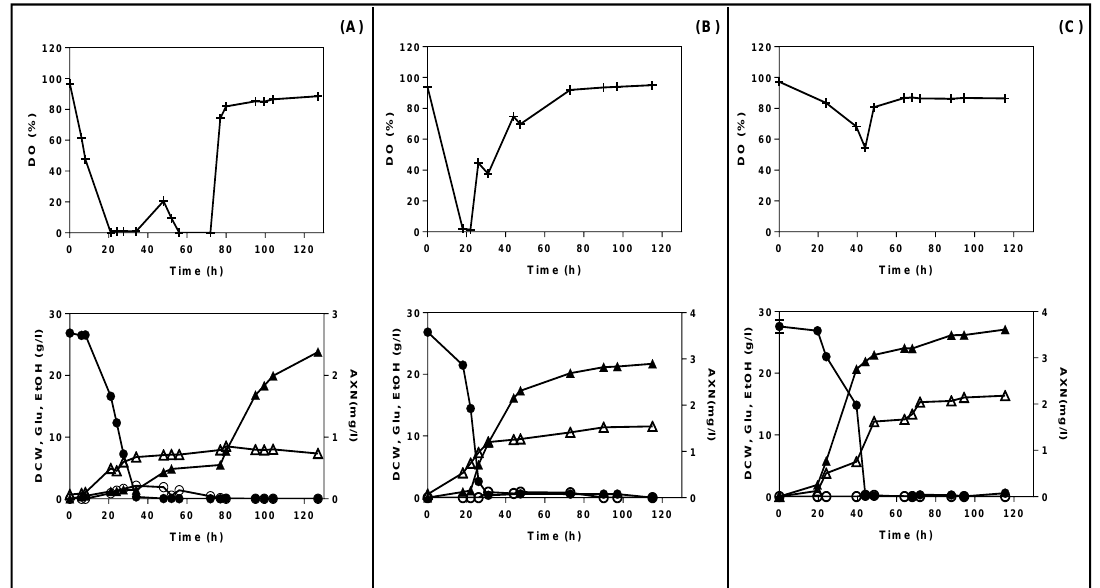
Figure 2. Effect of agitation speed on cell growth, glucose consumption, and astaxanthin and ethanol production in a 2-L bioreactor using semi-defined media with 30 g/L of glucose as carbon source. ( A ) 250 rpm; ( B ) 400 rpm; ( C ) 600 rpm. Fermentation conditions: aeration, 1 L/min; temperature, 20 °C; pH 6. Symbols represent: ( ▲) astaxanthin, AXN (mg/L); (●) glucose, Glu (g/L); (∆) dry cell weight, DCW (g/L); ( ○) ethanol, EtOH (g/L); (+) dissolved oxygen, DO (%).